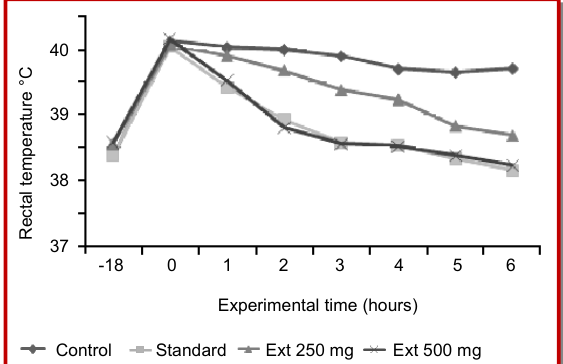
Figure I: Antipyretic effect of hydro-methanol extract of M. azedarach leaves (250 and 500 mg/kg p.o) in rabbits; -18 = Temperature just before yeast injection; 0 = Temperature just before drug